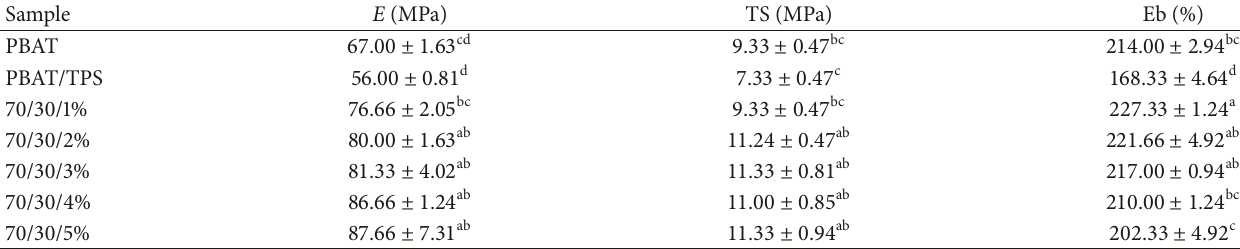
Table 2: Mechanical properties of PBAT, PBAT/TPS, and PBAT/TPS/SNP